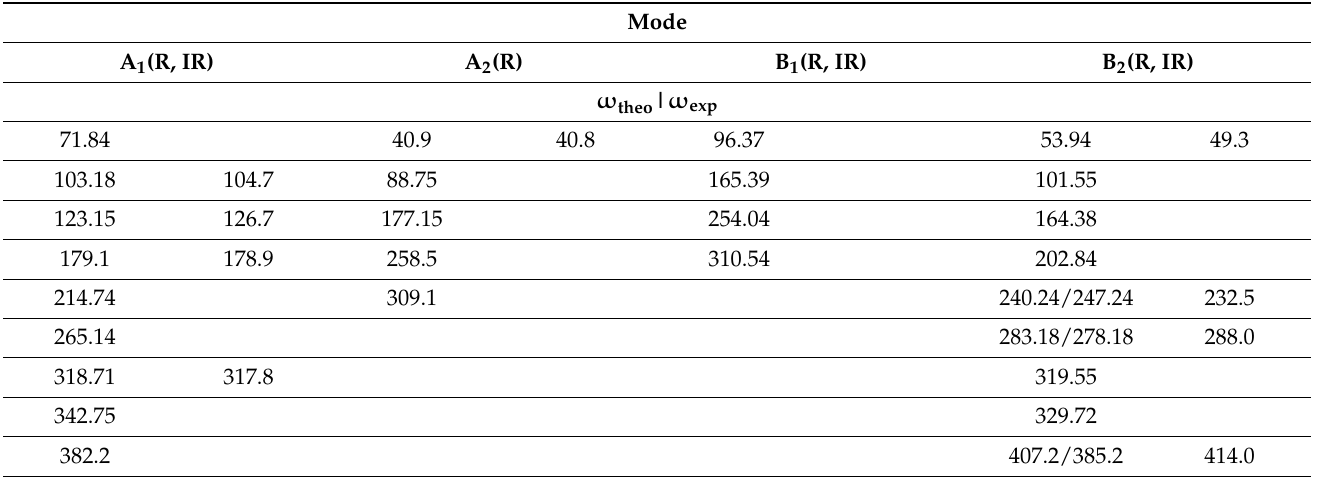
Figure 9. Raman spectrum of the GaInS 3 compound. Table 1. Calculated ω theo and experimentally measured ω exp eigenfrequencies of GaInS 3 . All frequencies are given in (cm − 1 ). LO-TO splitting is indicated by a